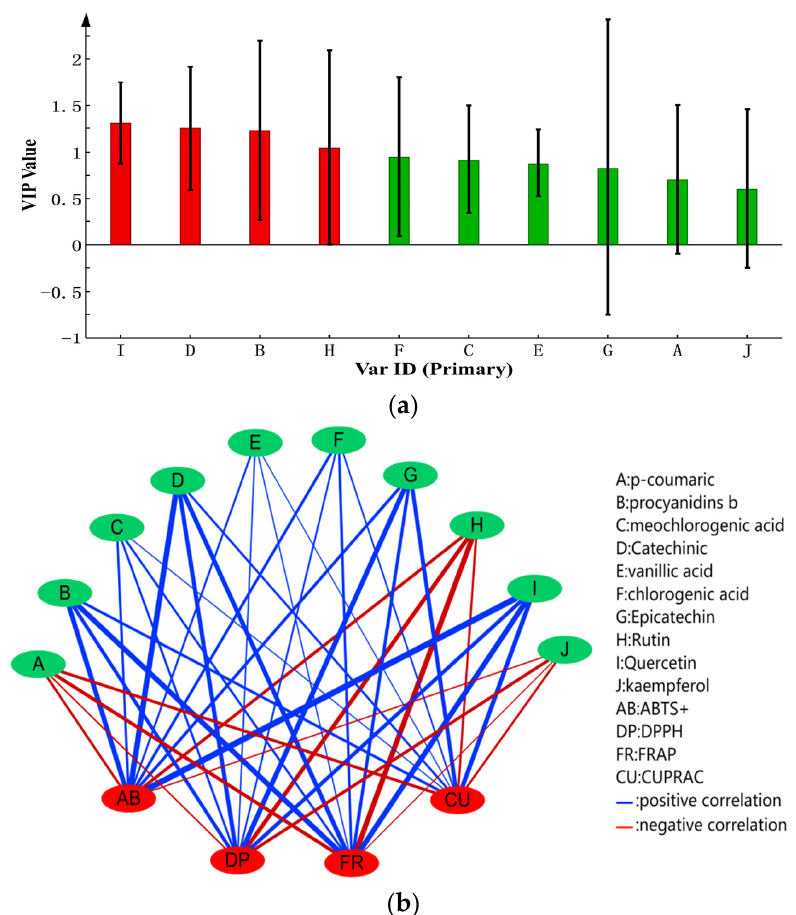
Figure 2. ( a ): The VIP value derived from OPLS analysis characterized the correlation value of the antioxidant capacity. A VIP value greater than 1.0 means significant correlation to the antioxidant capacity. ( b ): Correlations between antioxidant capacities and phenolic compounds in seven peach cultivars. The width of the line is proportional to the strength of the correlation.